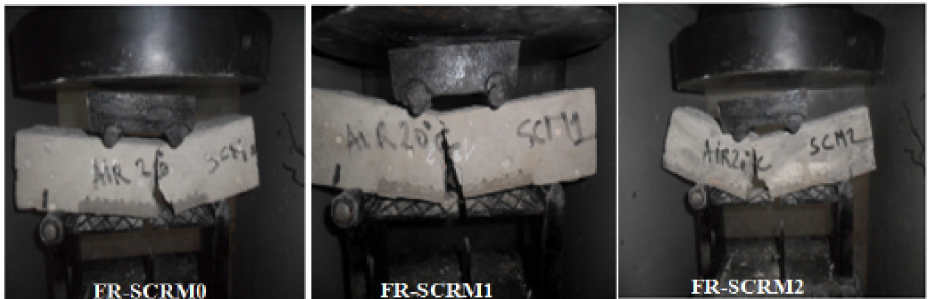
Figure 6. Breakage of specimens with fiber